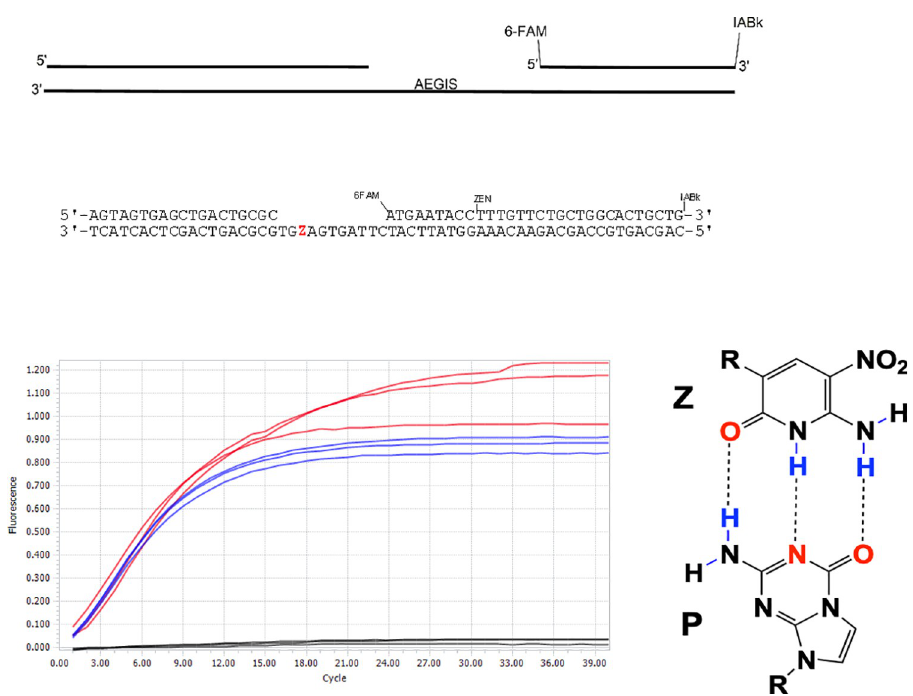
Fig 13. Taqman 1 assay in droplets. Top: Scheme of the Taqman 1 assay containing AEGIS (dZ:dP pair hydrogen bonding shown). Bottom: Real-time fluorescence detected from a probe. The probe contains a 5 0 fluorophore: 6-carboxyfluorescein (6FAM) and is double-quenched with: 3 0 Iowa Black ™ (IABk) and a proprietary internal ZEN quencher(IDT). When Taq [R587Q E832C] polymerase places a dZ opposite dP and the 5’-3’ exonuclease of Taq polymerase cleaves the probe eventually releasing a fluorescent molecule. The blue line is the fluorescence from a non- emulsified reaction. The red line corresponds to the signal from the emulsified reaction. The emulsion was made by mixing 100 μ Lof aqueous phase with 300 μ Lof a fluorinated oil with 2% (v/v) fluorinated surfactant as shown on Fig 2. Mixed in QIAGEN TissueLyser II in the presence of a 6 mm stainless steel bead at 15 Hz for 10 seconds followed by 17 Hz for 7 seconds using an Eppendorf Safe-Lock Tube (2 mL) containing a stainless steel ball. Assays were done by triplicate.